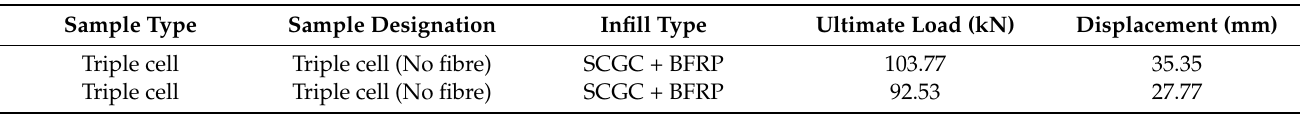
Table 5. Results from triple-cell infill